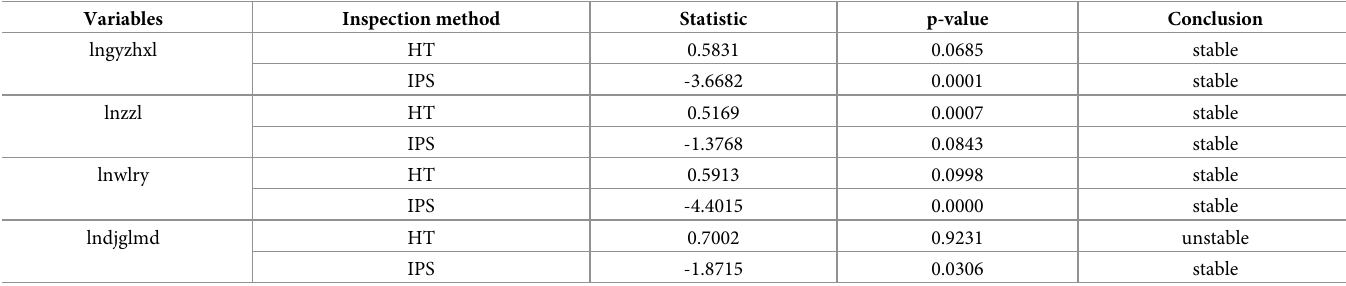
Table 4. Description of unit root test results of variables.